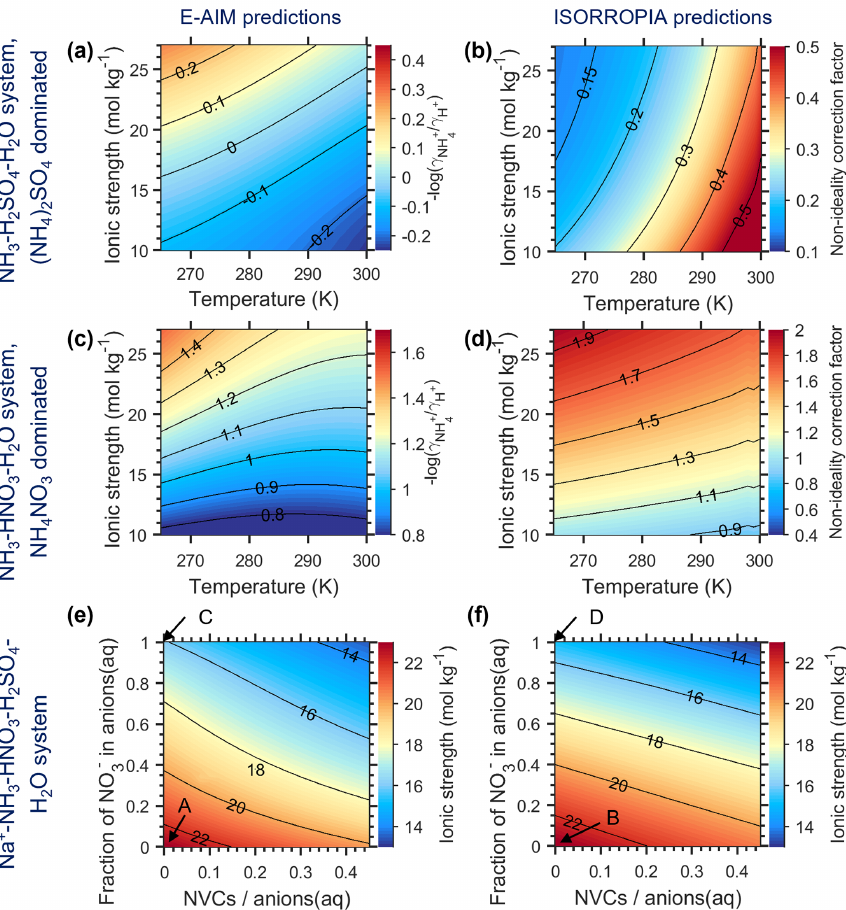
Figure A1. Ionic strength ( I ) and the non-ideality correction factor, c ni , as calculated by E-AIM (a, c, e) and ISORROPIA (b, d, f) under different aerosol systems. The systems are the same as in Fig. 1, while the RH in Fig. 1a–d and c ni in Fig. 1e–f are replaced by I